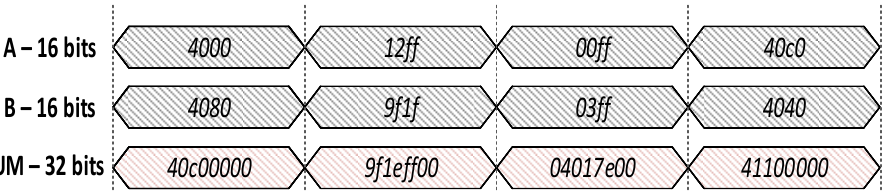
Figure 12. 16-bit Adder with output in 32 bits.